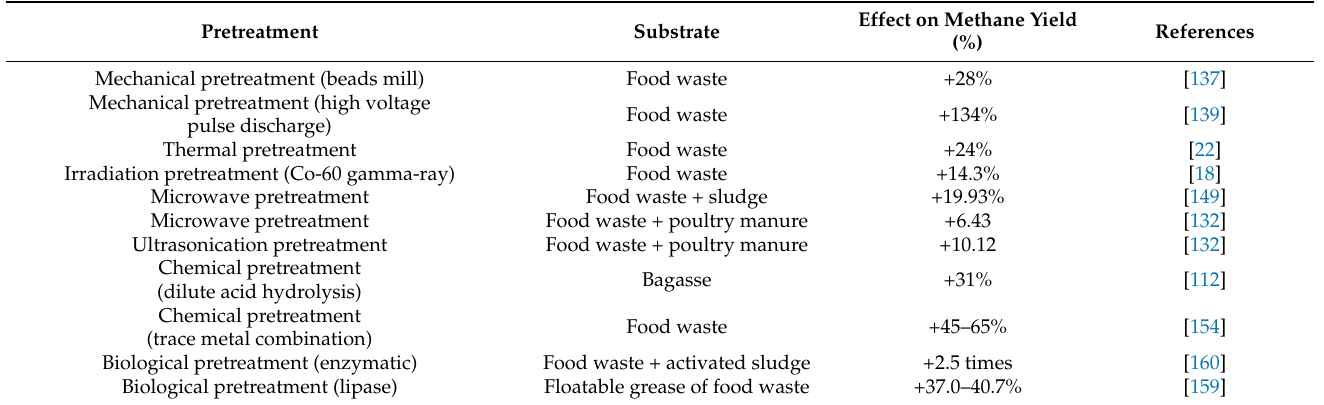
Table 1. Food waste pretreatments overview—Selection of food waste